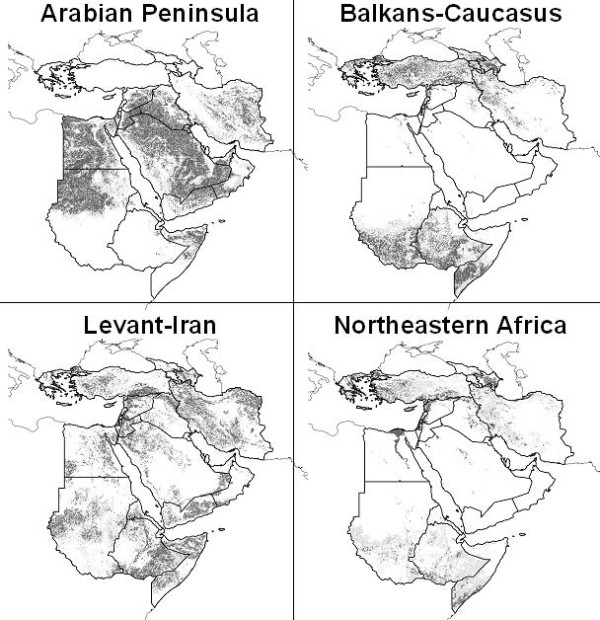
Projections of HPAI H5N1 occurrences from a single subregion across the whole region. Light grey = 5–9 models predict potential presence, dark grey = all models agree in predicting presence. Note the contrast between the Arabian Peninsula and the other three predictions.